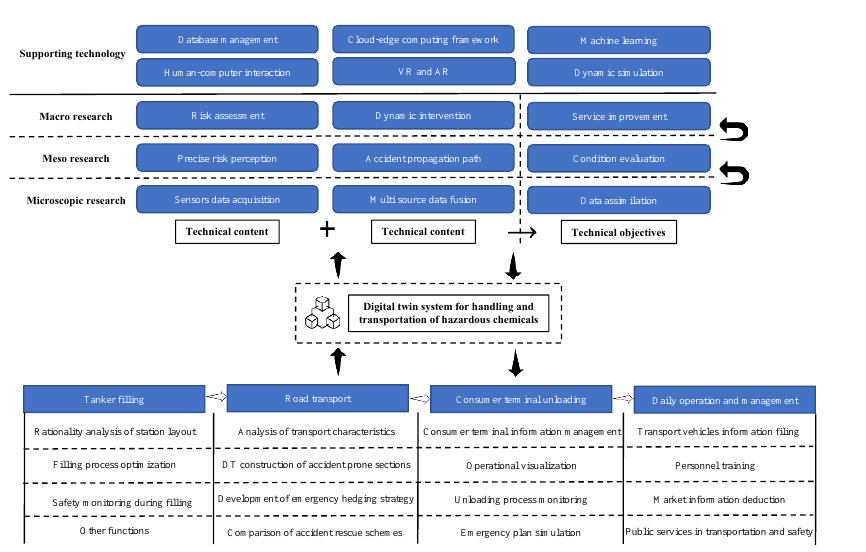
Figure 5. LNG digital twin system features.